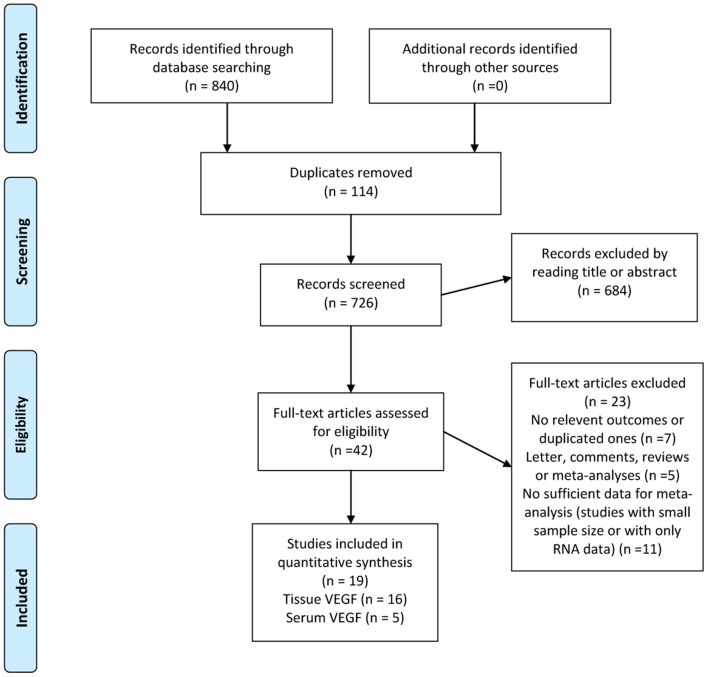
Selection process for studies to be included in the meta-analysis in compliance with MOOSE (Meta analysis of Observational studies in Epidemiology) standards.